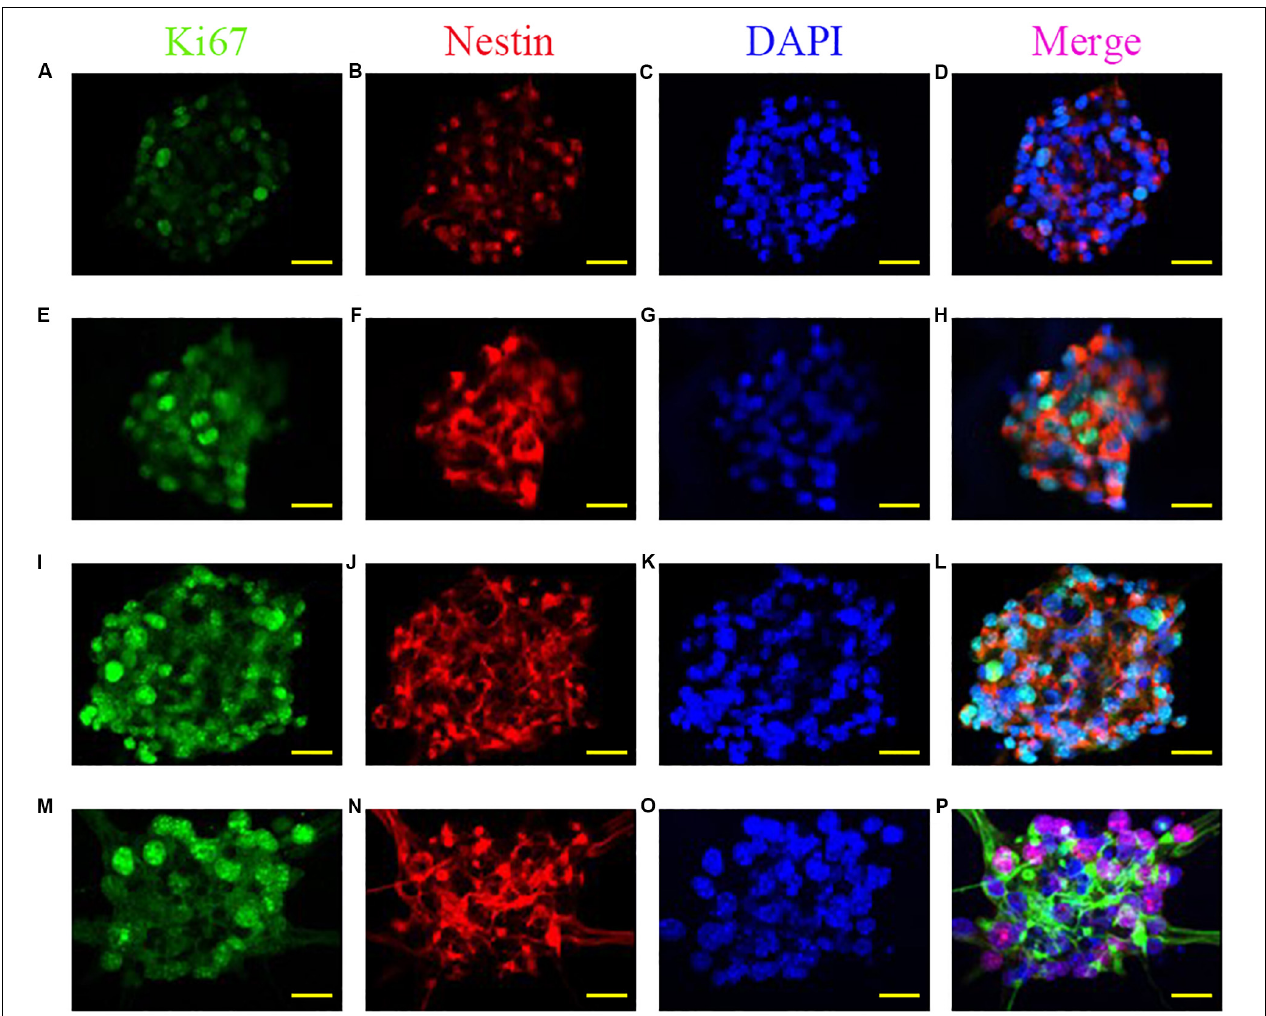
FIGURE 3 | Promoted formation of neural stem cell spheroids. Fluorescent images of Ki67, Nestin, DAPI, and merged images of neural stem cell spheroids cultured on the PVDF control (A–D) , on the inverse opal substrate (E–H) , on the 3 × stretched substrate (I–L) , and on the 6 × stretched substrate (M–P) . Scale bars are 20 µ